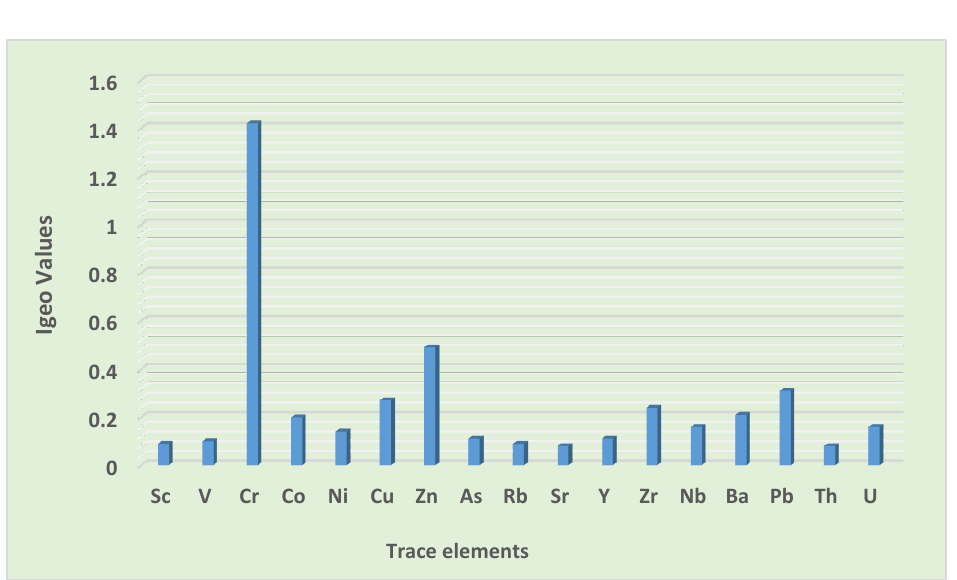
Figure 3. Trace element contamination levels in road dust based on Igeo values. Table 6. Geo-accumulation (Igeo) values of trace element contamination in road dust.